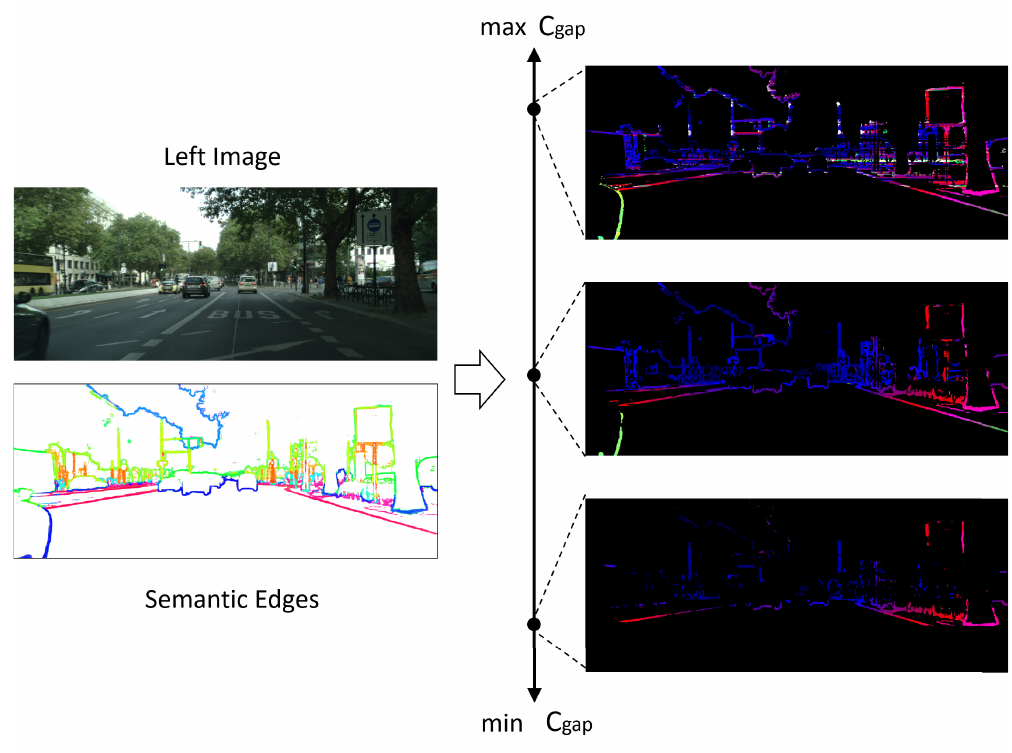
Figure 3. Influence of different C gap s. Too small C gap will cause lots of unmatched pixels, while too large C gap will cause lots of